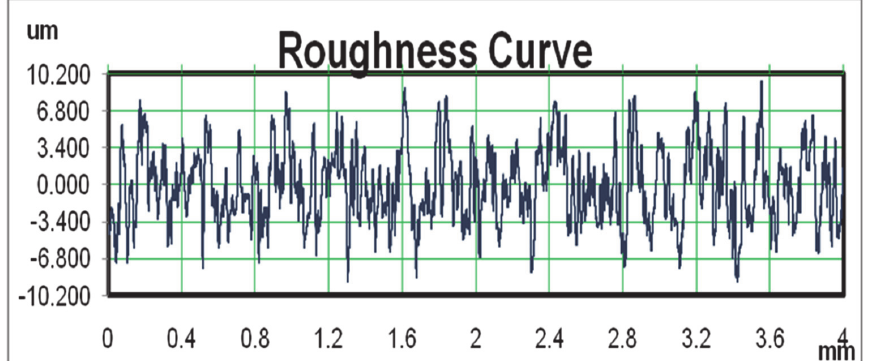
Fig. 5. Roughness curve for optimum setting of control factors (A 4 B 2 C 4 D 4 E 2 F 4 )